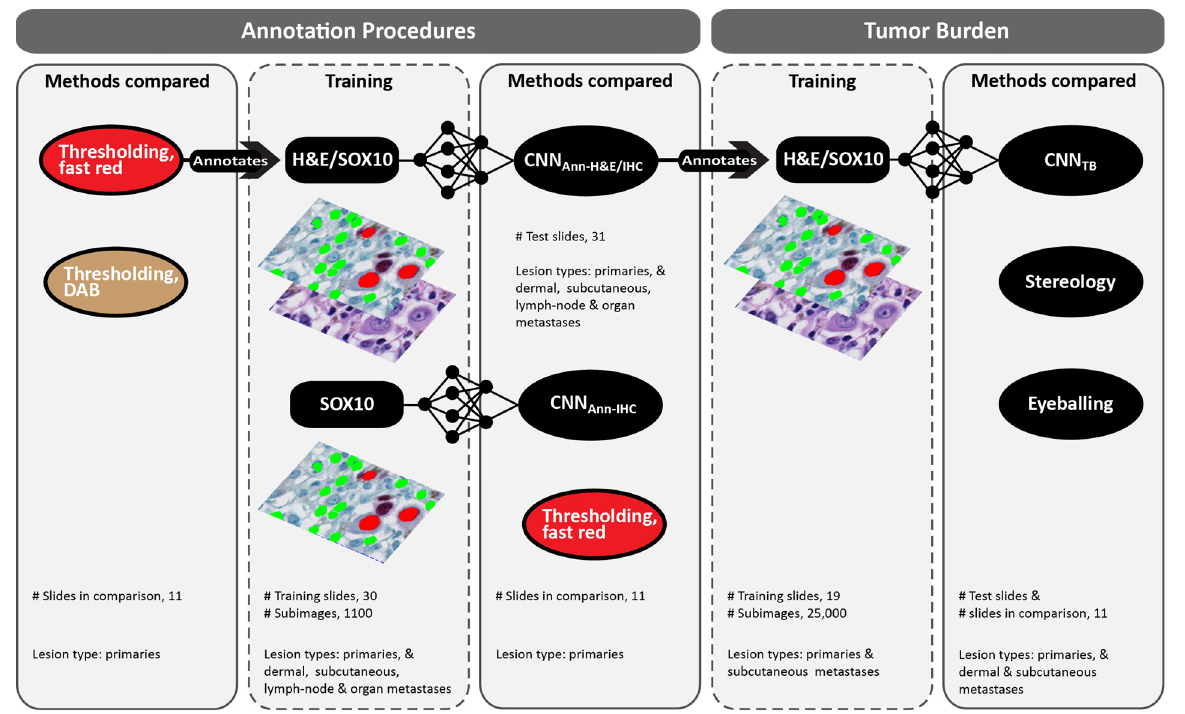
Figure 3. Development of annotation procedures and convolutional neural network for calculating tumor burden (CNN TB ), and methods compared. Initially, annotation by thresholding using either the red or the brown chromogen of IHC were compared. Thresholding of Fast-Red stains then assisted annotation of digital H&E/IHC dual stains, which was used to train two CNNs for annotation; one with RGB input from IHC ( CNNAnn-IHC ) and one with RGB input from both H&E and IHC ( CNNAnn-H&E-IHC ). The best-performing algorithm annotated the training set of CNN TB. Both CNN TB and routine eyeballing of pathologists were compared with stereological counts. Table 1. Histopathological Characteristics of Included